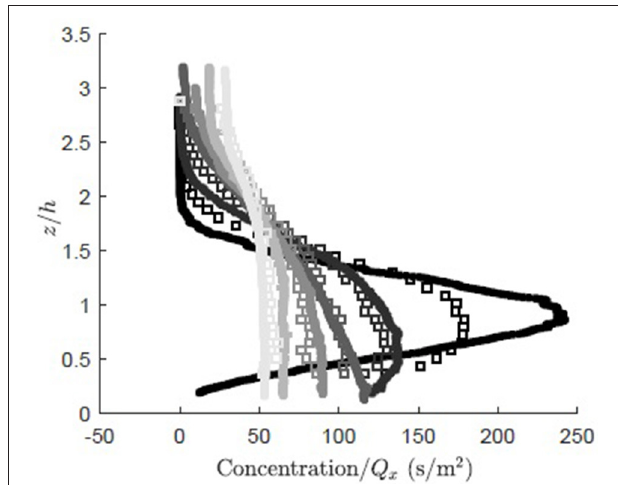
FIGURE 4 | Comparison of concentration normalized by total mass flux for RDM particles (open squares) and measured dye concentration (solid dots, case I, Ghisalberti and Nepf, 2005) at six longitudinal locations ( x / h 6.6, 10.8, 18.0, 27.3, dark to light gray). The concentration (g/m 2 ) was normalized by the longitudinal flux, Q x